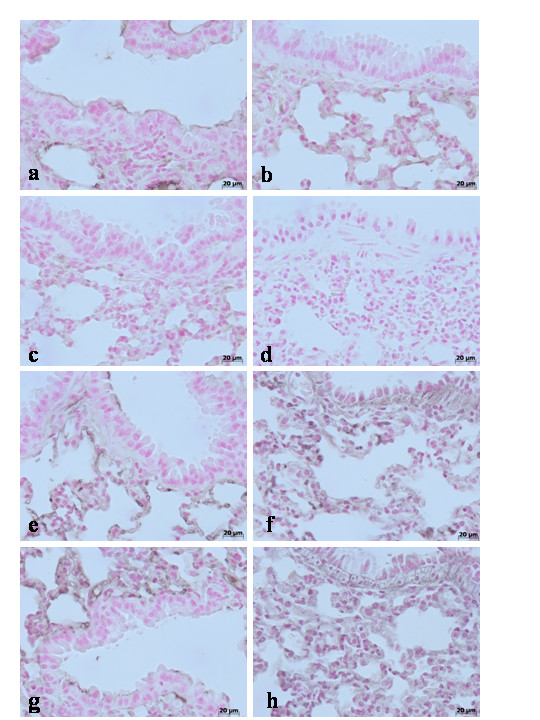
Immunohistochemical localization of ZO-1 in the lung. In lung tissue sections collected at 24 hours from sham WT mice (a) and from sham TNF-αR1KO mice (b), ZO-1 was uniformly and continuously distributed along the alveolar epithelium and the vascular endothelium. In contrast, a significant disruption of immuno-signal for ZO-1 was observed along the alveolar epithelium and the vascular endothelium in the lung sections of carrageenan-treated WT mice at 4 h (c) and at 24 hours (d) after carrageenan. In lungs of carrageenan-treated TNF-αR1KO mice, a more regular distribution pattern of ZO-1 along the alveolar epithelium and the vascular endothelium was found at 4 h (e) and at 24 hours (f), thus indicating that in carrageenan-treated TNF-αR1KO mice carrageenan treatment provokes a lower degree of disorganization of ZO-1. Similarly, the treatment of WT mice with Etanercept (5 mg/kg administered s.c. 2 h prior carrageenan) visibly and significantly reduced the disorganization of ZO-1 in the lung tissues collected at 4 h (g) and at 24 hours (h). Figure is representative of at least 3 experiments performed on different experimental days.